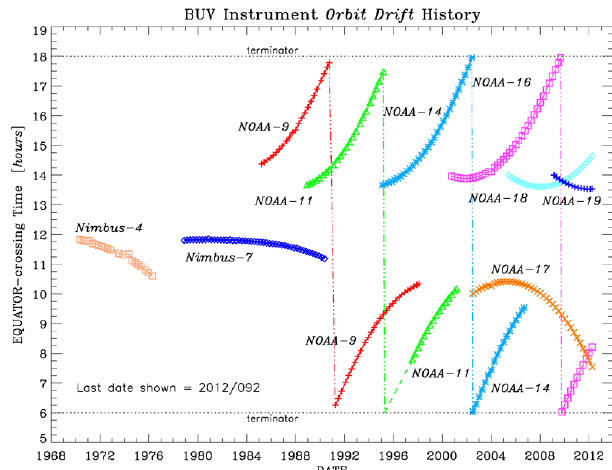
Fig. 7. Time series of Equator-crossing (EC) time for daytime ob- servations for all BUV instruments through April 2012. EC times between 12:00–18:00h (afternoon orbit) correspond to ascend- ing node daylight measurements. EC times between 06:00–12:00h (morning orbit) correspond to descending node daylight measure- ments. Dot-dash lines show when an instrument transitioned from afternoon orbit to morning